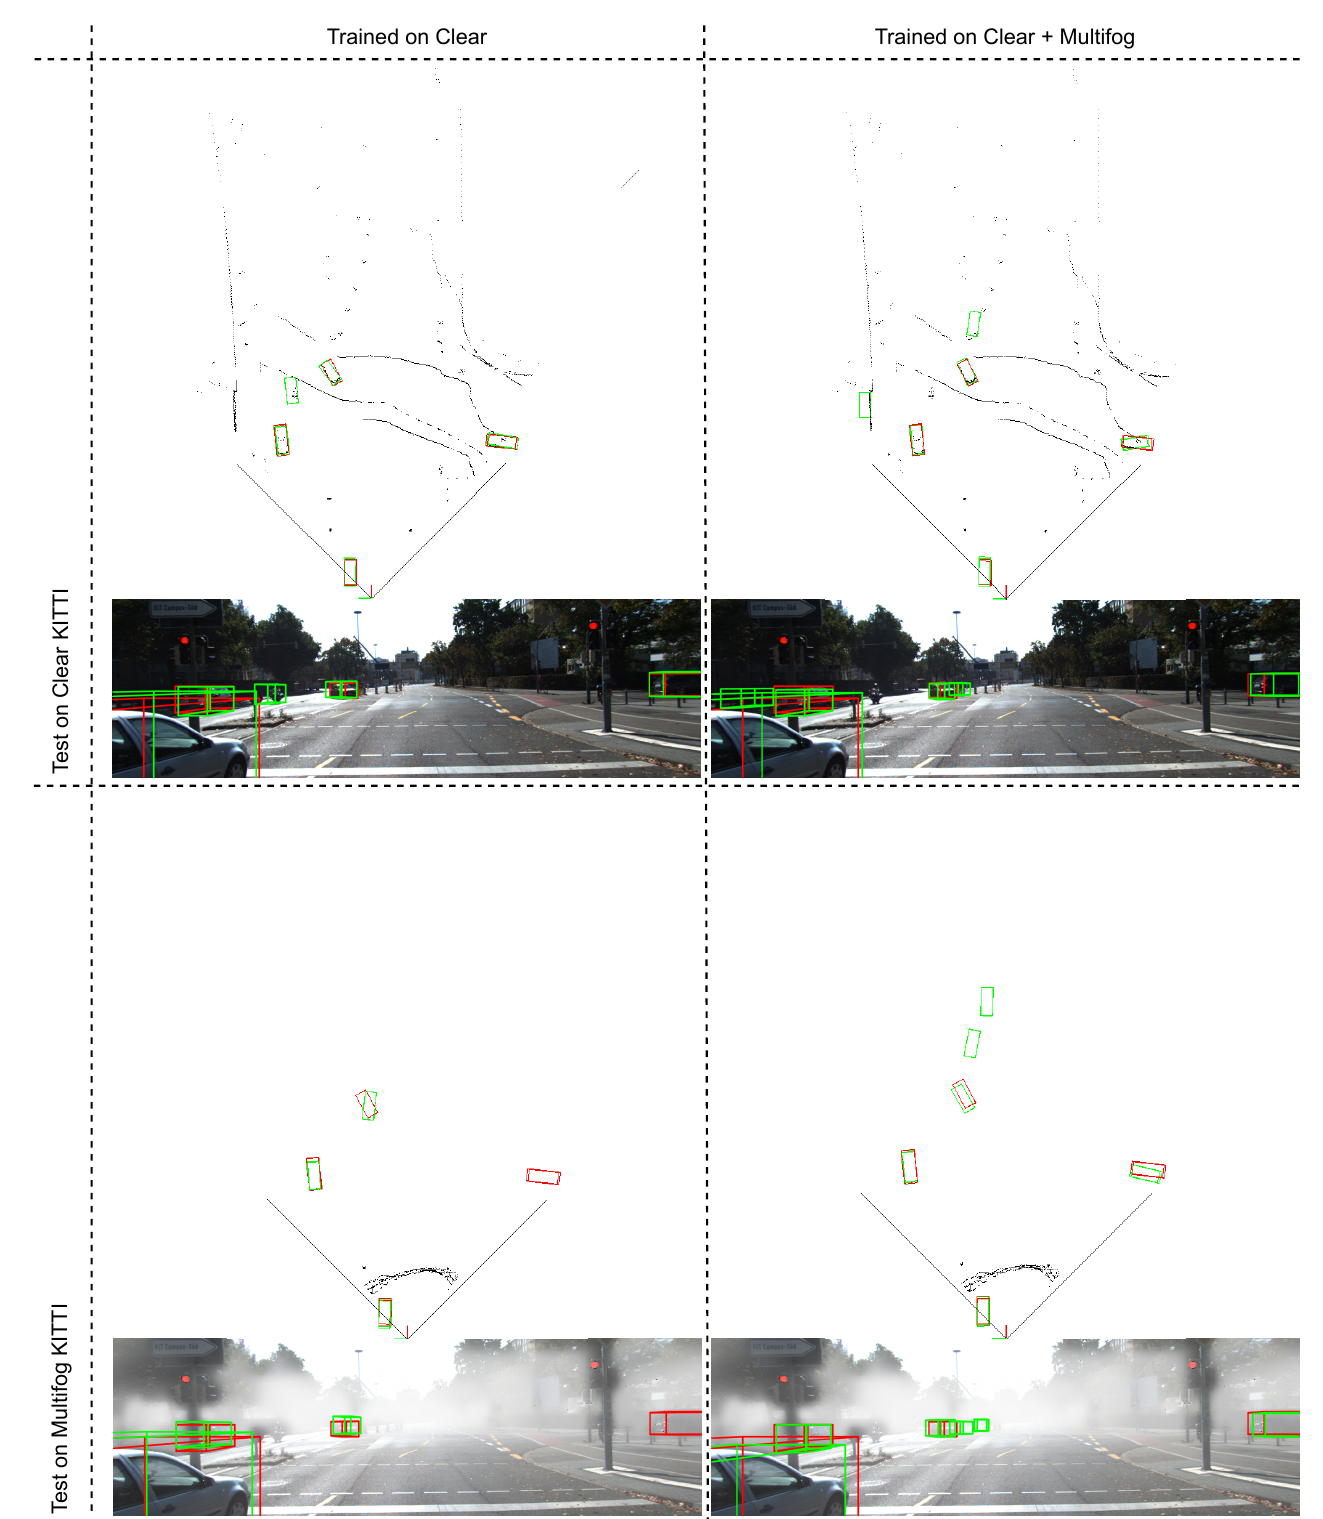
Figure 5. Qualitative results of our SLS-Fusion method for 3D object detection on the Clear KITTI dataset and the proposed dataset (Multifog KITTI). 3D bounding boxes in red and in green denote the ground truth and the prediction for objects in the scene, respectively. Note that the point cloud is shown in BEV